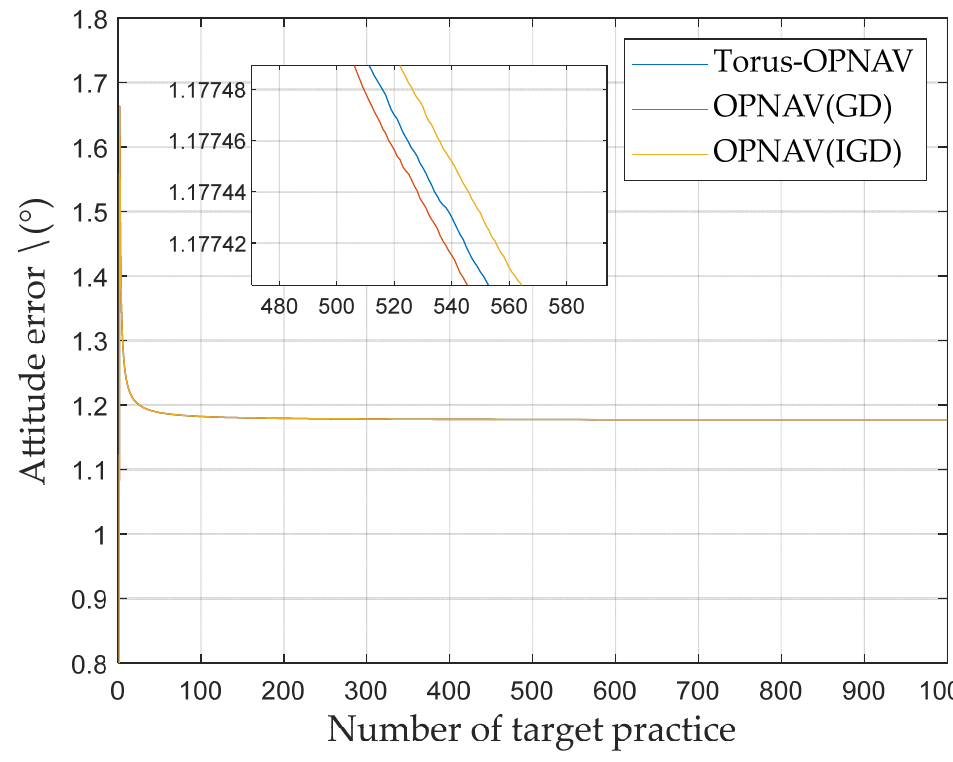
Figure 14. Attitude error of Torus-OPNAV, OPNAV(GD), and OPNAV(IGD).